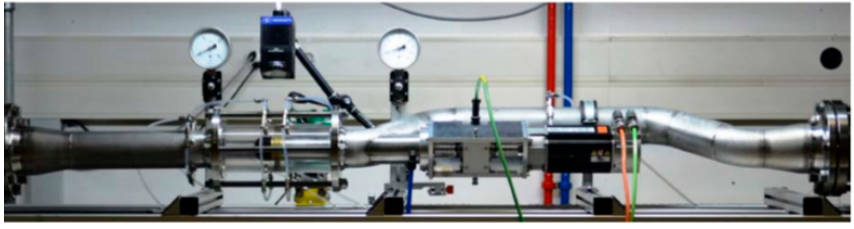
Figure 1. Experimental setup